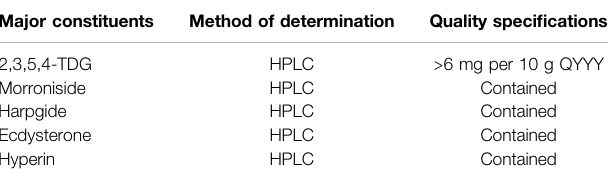
TABLE 2 | Quality evaluation of Qian Yang Yu Yin. Major